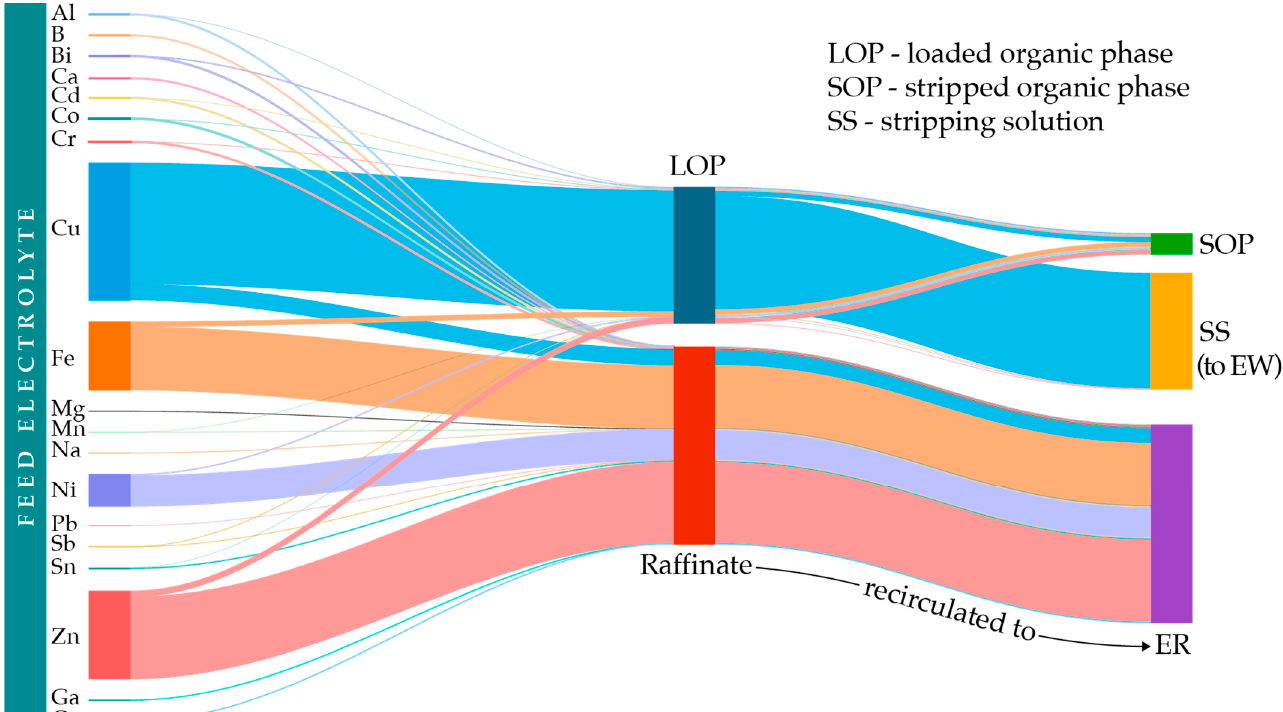
Figure 13. Metal distribution and mass balance of SX process.